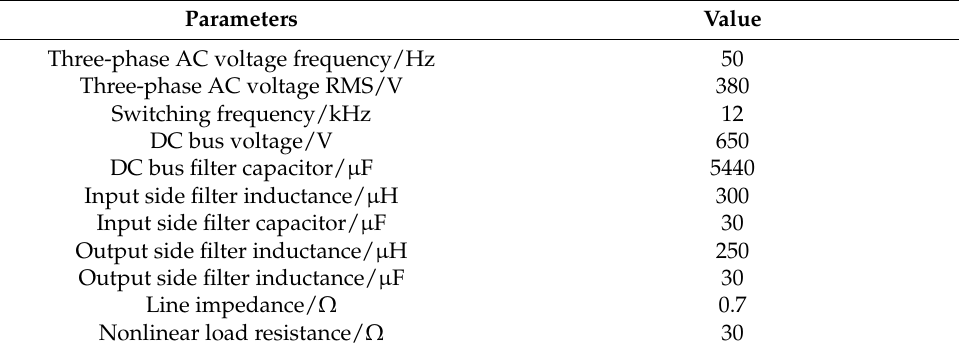
Table 3. System parameters of the experimental platform.